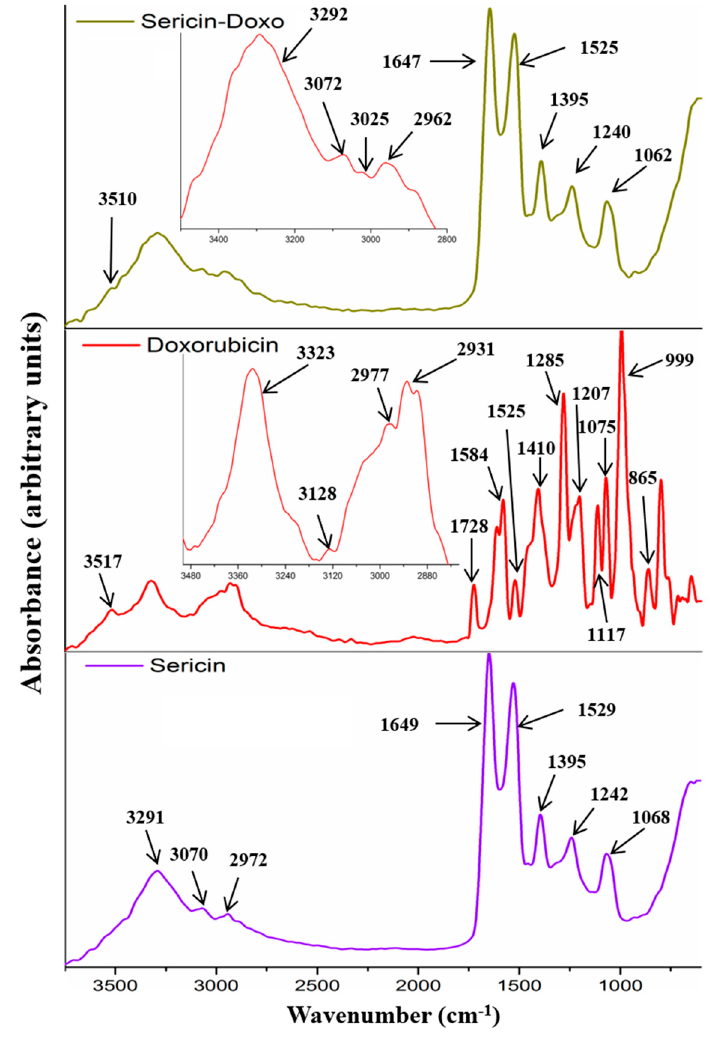
Figure 1. FTIR–ATR spectra of sericin, doxorubicin, and doxorubicin-loaded sericin nanoparticles. Both enzymes (protease IV and chymotrypsin) showed a typical protein-specific spectrum with amide I, amide II, and amide III. The main peaks are shown in Figure 2a,b. Sericin–doxorubicin interaction revealed a drug-specific peak at 3510 cm − 1 , assigned to the water molecules bonded within the drug molecules. Another important peak appeared at 3070 cm − 1 , attributed to unsaturated =C-H stretching vibration characteristic for the aromatic structures similar to doxorubicin structure. Therefore, FTIR analysis showed the presence of doxorubicin within the sericin structure. Furthermore, the analysis revealed no chemical bonds between the sericin and drug, suggesting that the association was induced only by physical interactions (Figure 1).